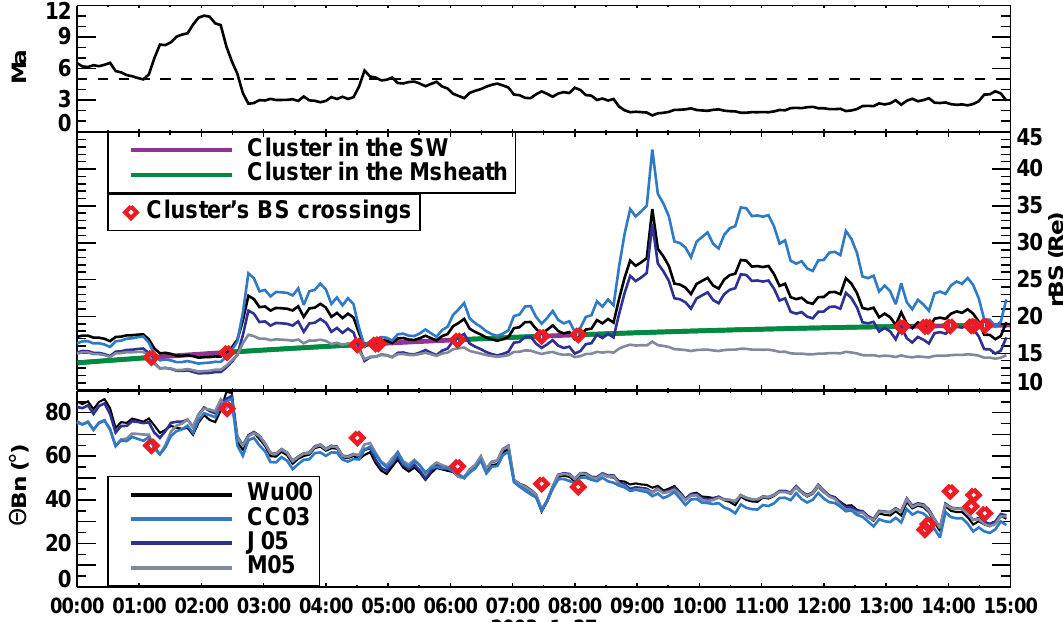
Fig. 3. Bow shock position and obliquity during the 27 January 2003 MC: models and observations – first panel: upstream Alfv´en Mach number calculated from ACE data (time shift: 45min) – second panel: predicted time variation of the bow shock geocentric distance in Cluster’s direction and Cluster’s trajectory – third panel: predicted time variation of 2 Bn at Cluster’s location – red diamonds: Cluster’s bow shock